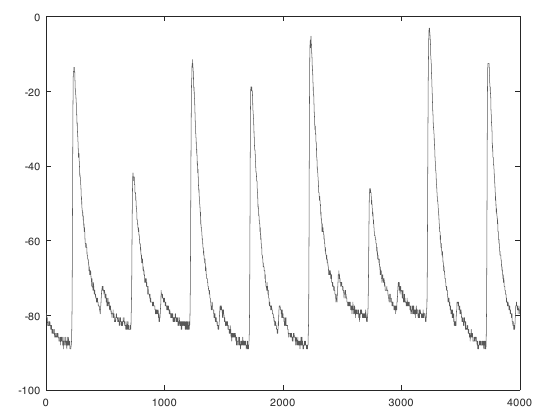
Figure 3. A single captured power measurement. The amplitude has a -100 mV offset.